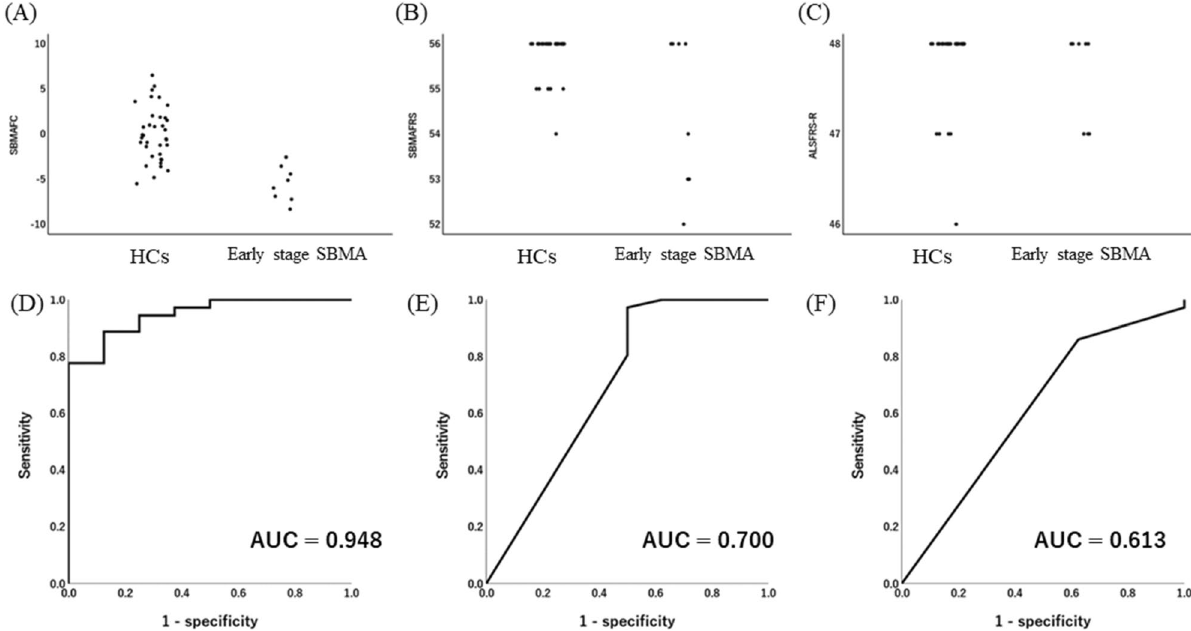
Figure 2. SBMAFC, SBMAFRS, and ALSFRS-R in early-stage SBMA ( A–C ). Score distribution of SBMAFC, SBMAFRS, and ALSFRS-R. A ceiling effect in healthy controls (HCs) was not shown for SBMAFC, but was clearly detected for SBMAFRS ( B ) and ALSFRS-R ( C ). ( D–F ). A receiver operator characteristic (ROC) analysis of SBMAFC ( D ), SBMAFRS ( E ), and ALSFRS-R ( F ).